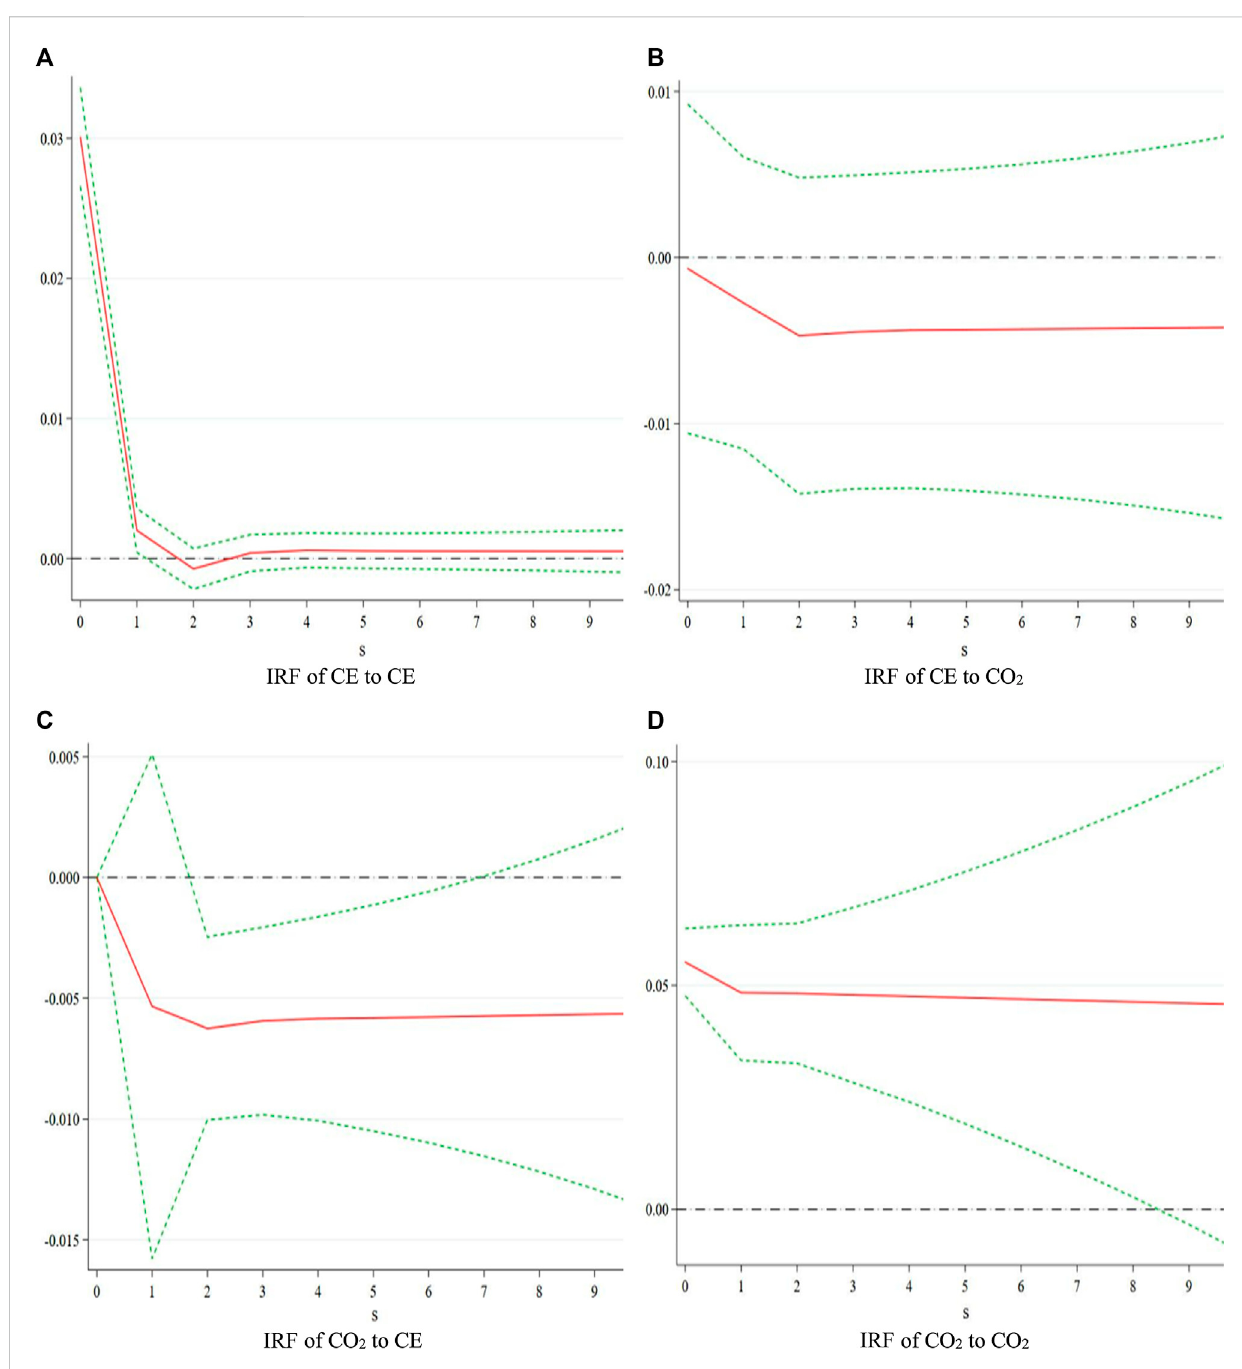
FIGURE 2 Impulse response function. (A) IRF of CE to CE, (B) IRF of CE to CO 2 , (C) IRF of CO 2 to CE, (D) IRF of CO 2 to CO 2 .